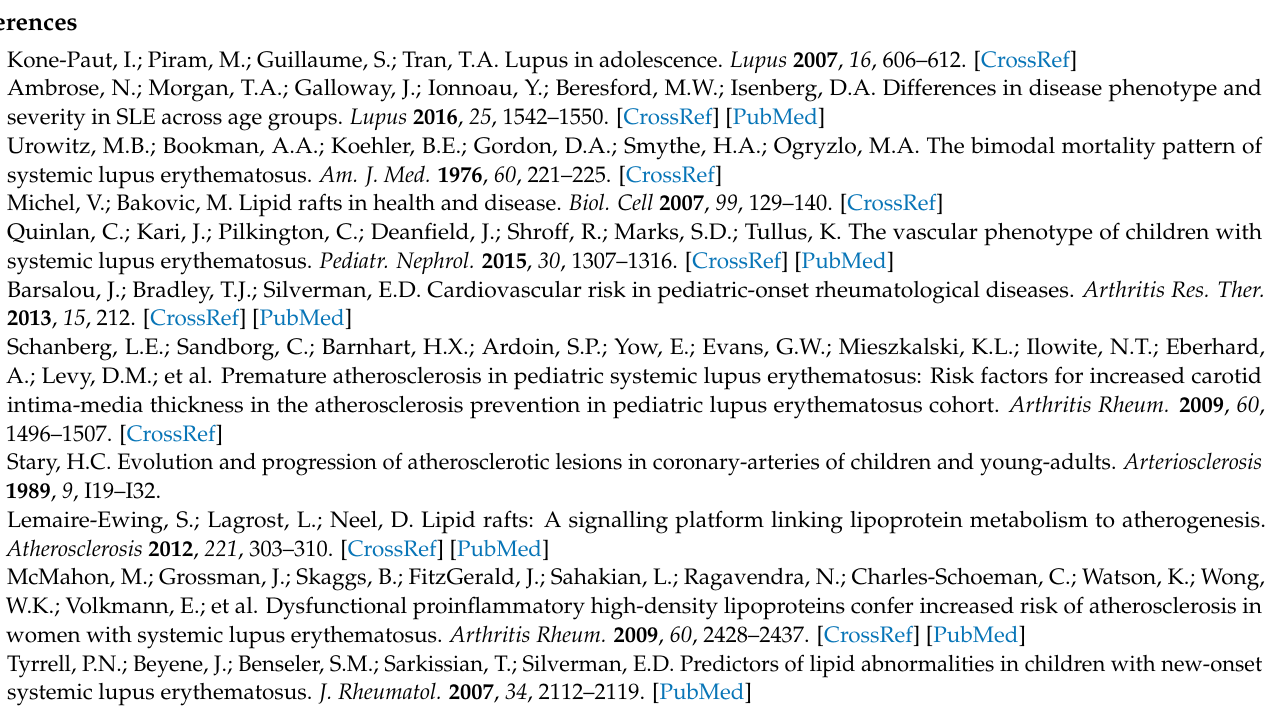
Figure S4: Immune cell lipid metabolism is stimulated by in vitro culture with serum from JSLE patients with active